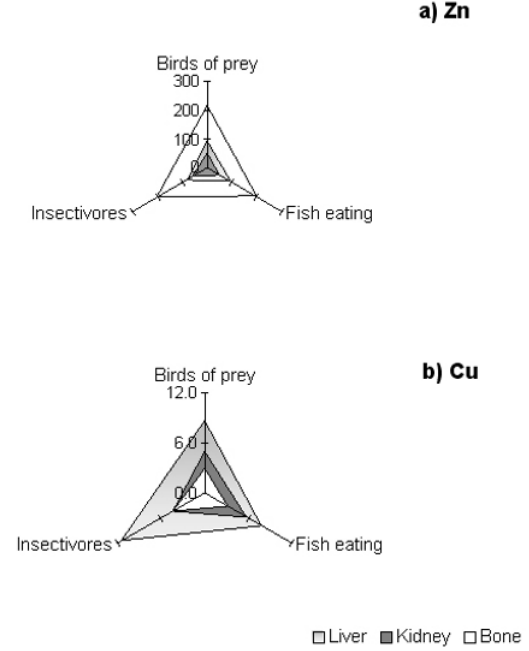
Figure 3. Comparative Zn and Cu concentrations in liver, kidney and bone samples of